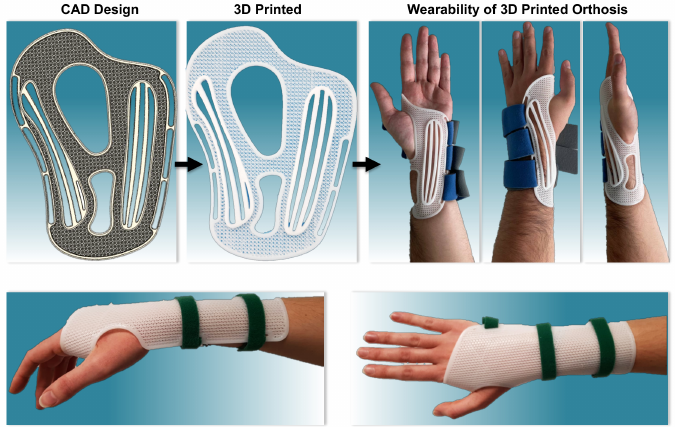
Figure 7. CAD design and wearability of 3D printed lattice-based orthosis. Representative images of shape memory 3D printed orthosis with reticular (upper images) and triangular (below images) lattice structures.